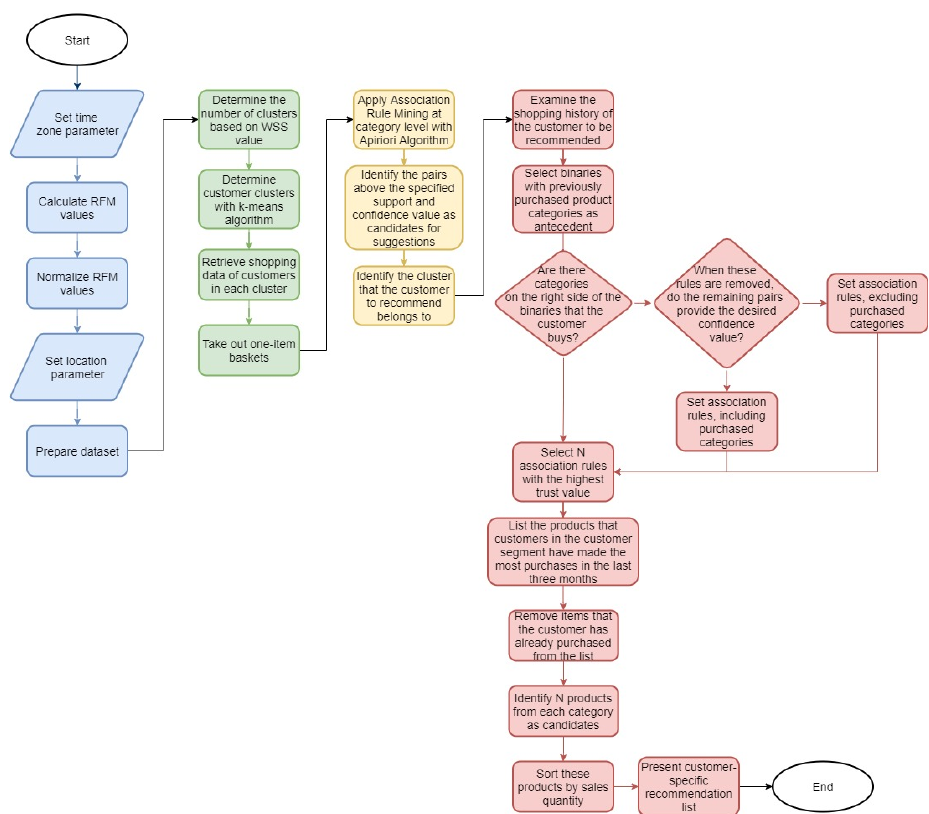
Figure 5. Flowchart of the proposed recommendation system.